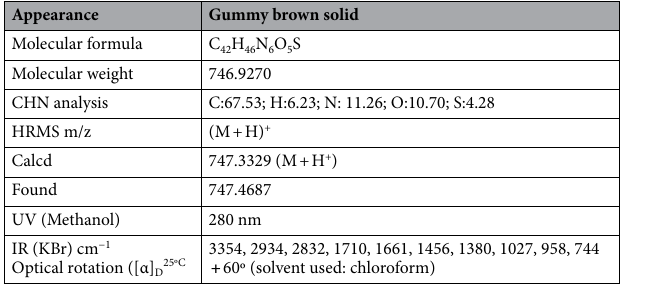
(Table 1). The molecular formula was determined to be C 42 H 46 N 6 O 5 S based on HRMS analysis data by consider- ing the number of protons and carbons from NMR spectrum (Table 2). Sulfur atom is predicted to be present